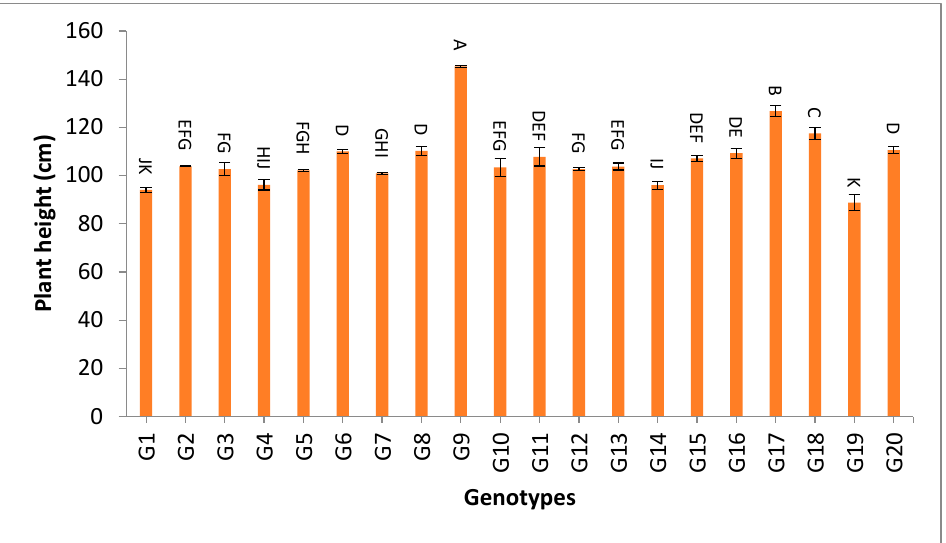
Figure 2. The mean values of plant height (cm) of twenty rice genotypes over the two years. Bar represents the standard deviation. Different alphabetic letters represent the significant differences among the genotypes at p < 0.05, based on Duncan’s multiple range test.